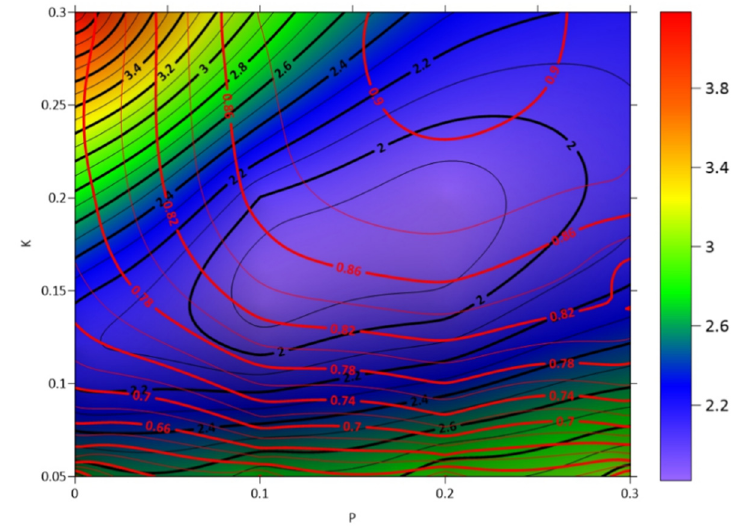
Figure 12. Superimposition of the RMSE surface (black contour lines) and the R 2 surface (red contour lines) for the annual LDR-equivalent climate (9° N). The x -axis is the groin permeability P , while the y -axis is the GENESIS transport coefficient K . Surfaces were obtained by comparing the “measured” and “predicted” LRR functions of each K – P scenario.